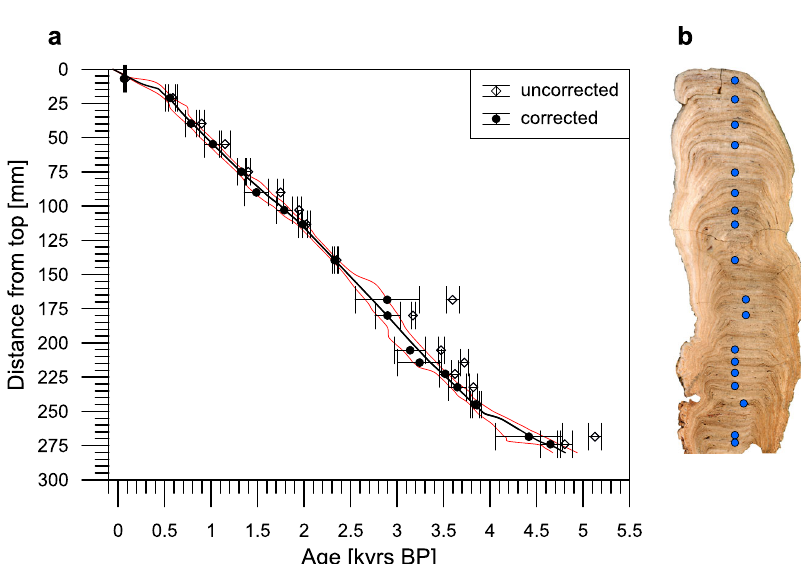
Fig. 2 New age-depth model of the MA1 stalagmite. a StalAge 34 age-depth model, including the corresponding 95% con fi dence limits (thin red lines). Uncorrected ages and ages after detritus correction 35 are shown with standard deviations as 2 σ error bars (see Table S1 for details). b Photo of MA1 including the 18 sampling points for 230 Th/U